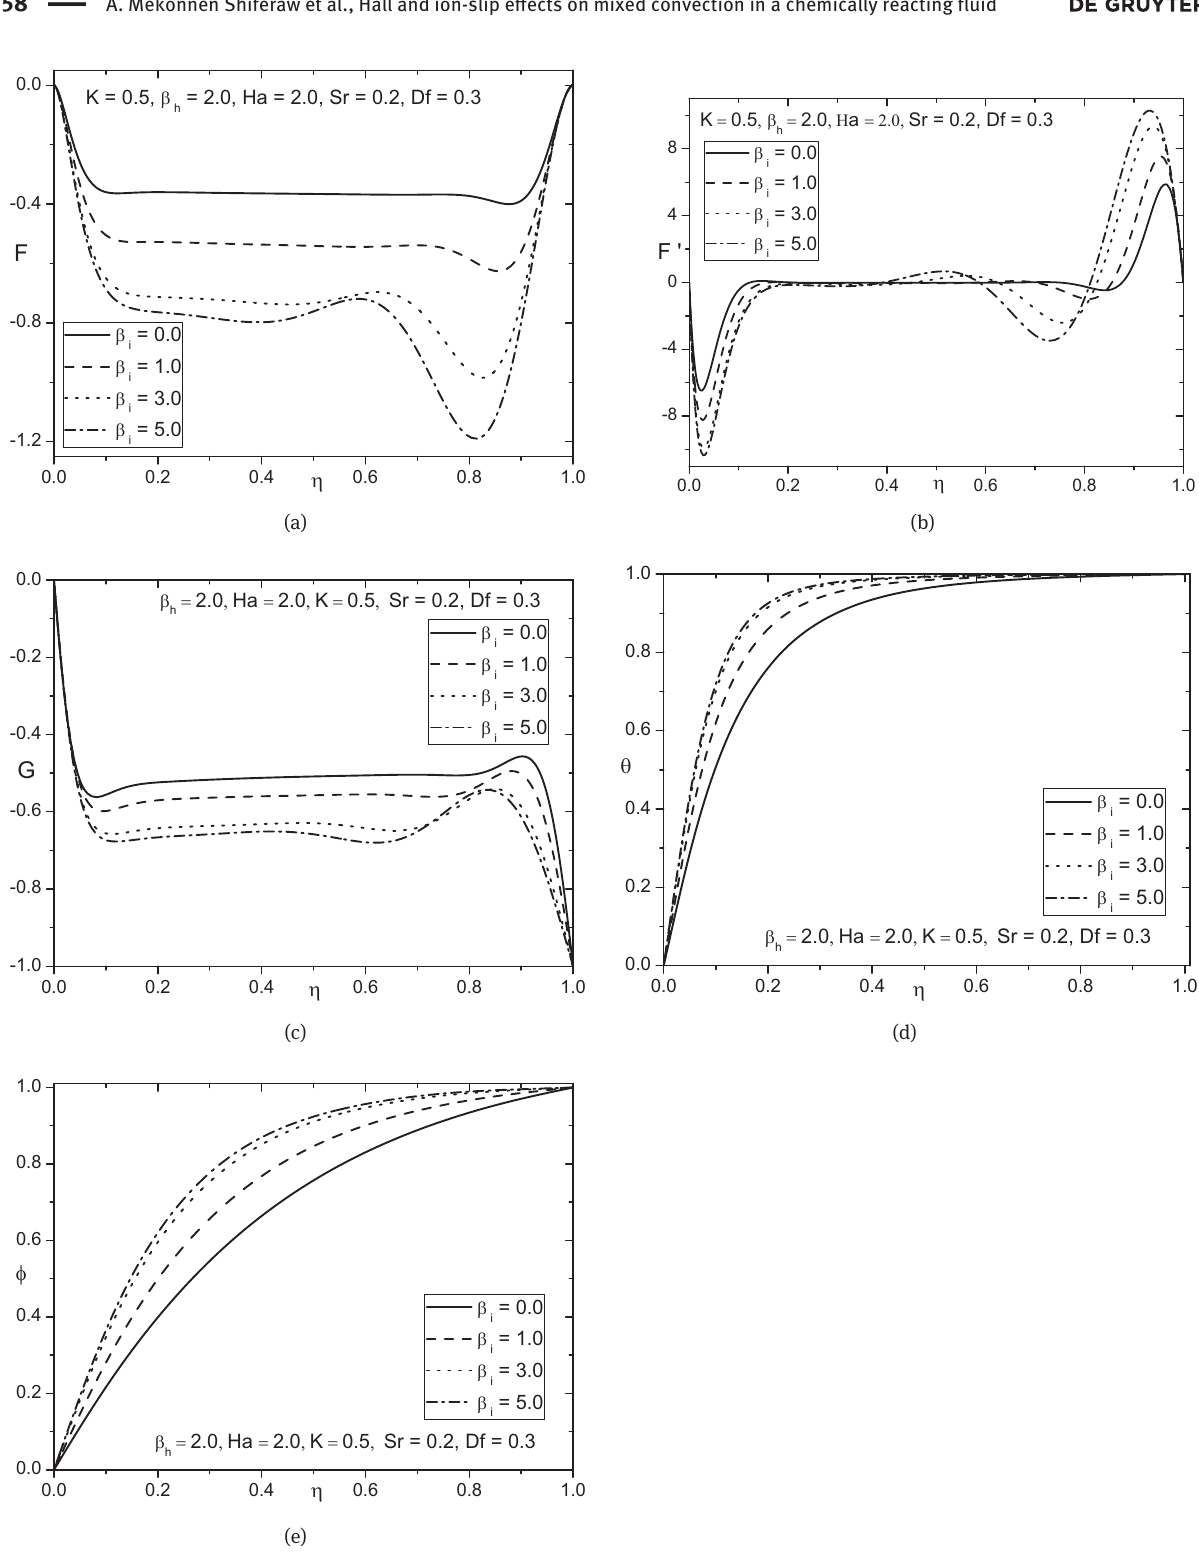
Fig. 3: Effect of ion-slip parameter on (a) axial velocity, (b) radial velocity, (c) tangential velocity, (d) temperature, and (e) concentration pro-